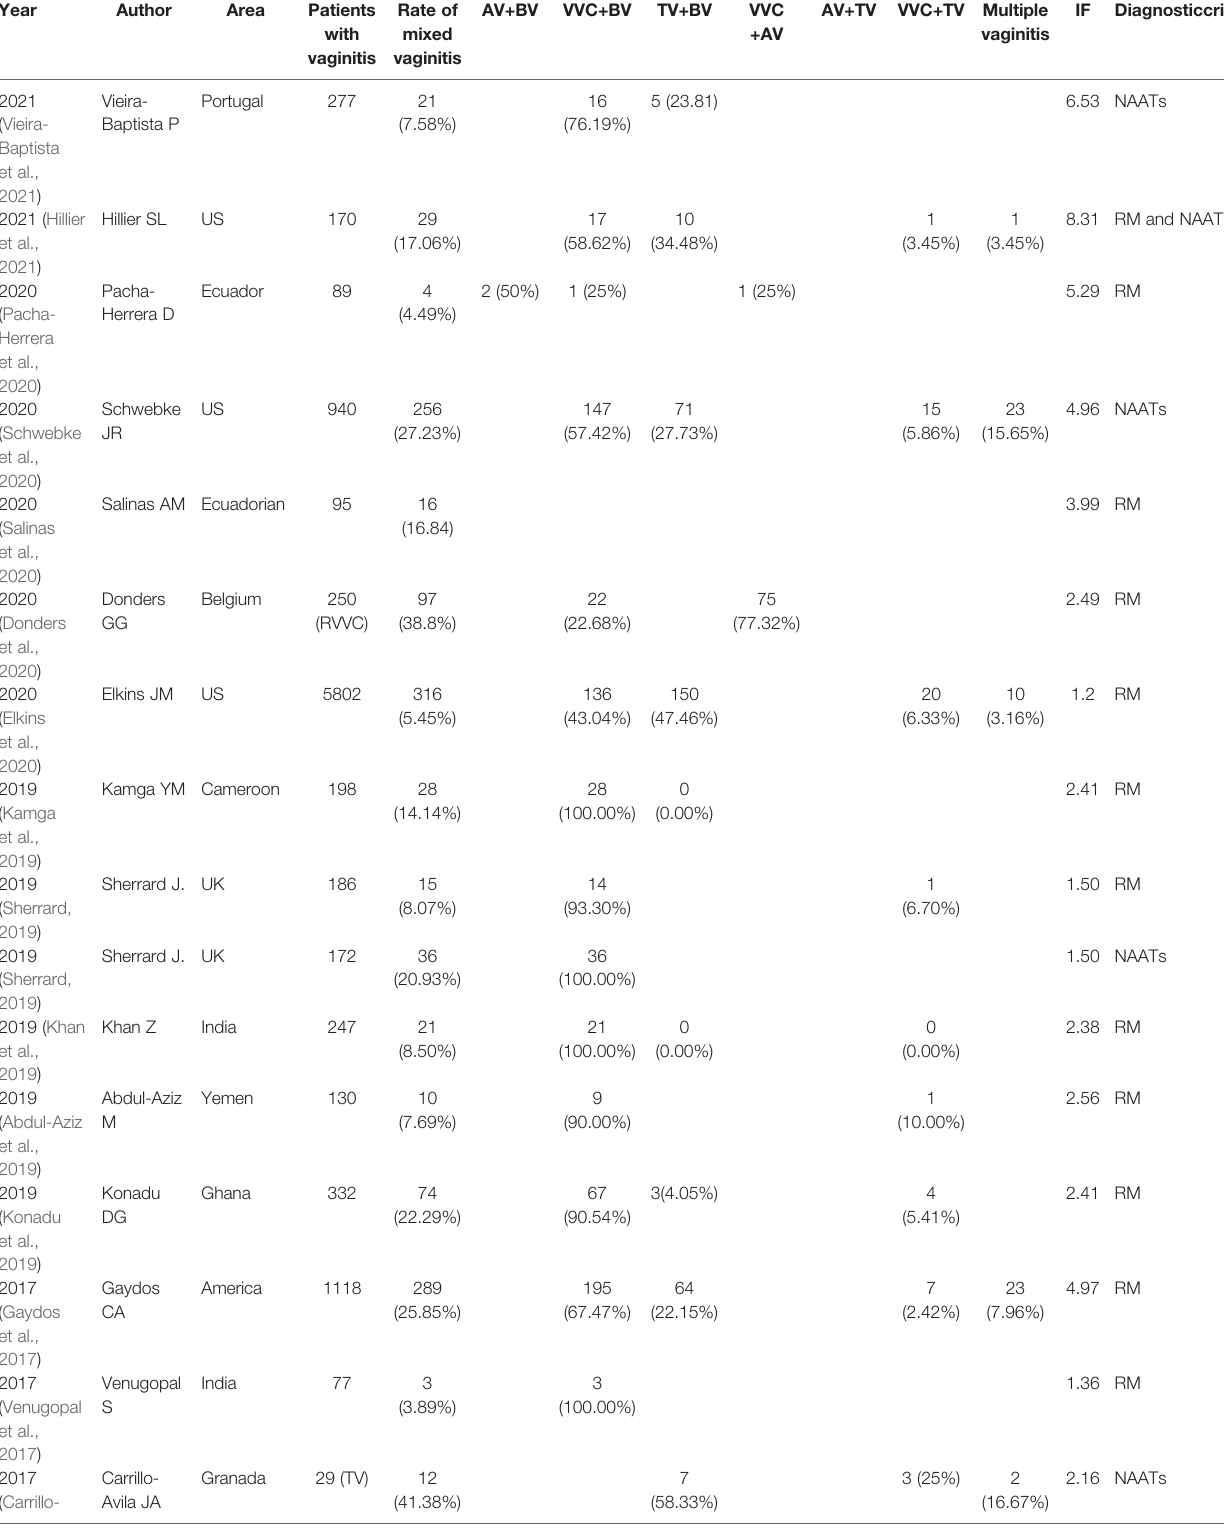
TABLE 1 | Summary of representative data of mixed vaginitis in the last 10